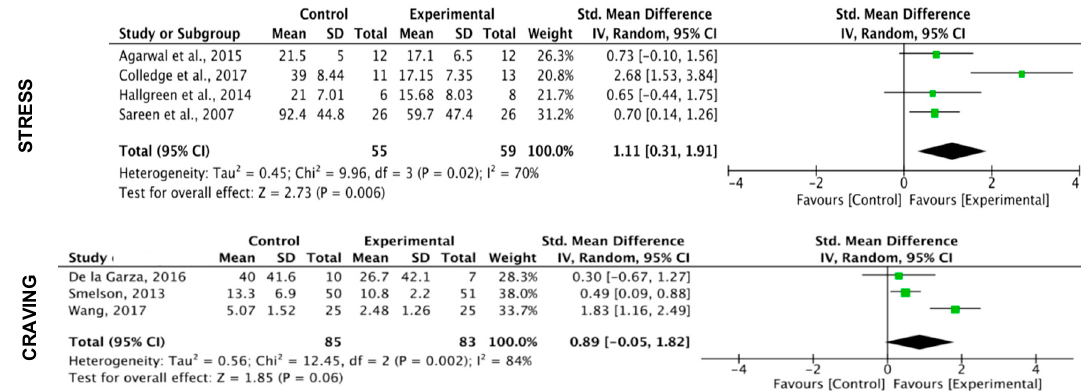
Figure 5. Effects of the exercise on mental disorders and craving (all programs included). Comparison between the effect of physical fitness (PF) programs and programs based on oriental practices (OP) Quality of life